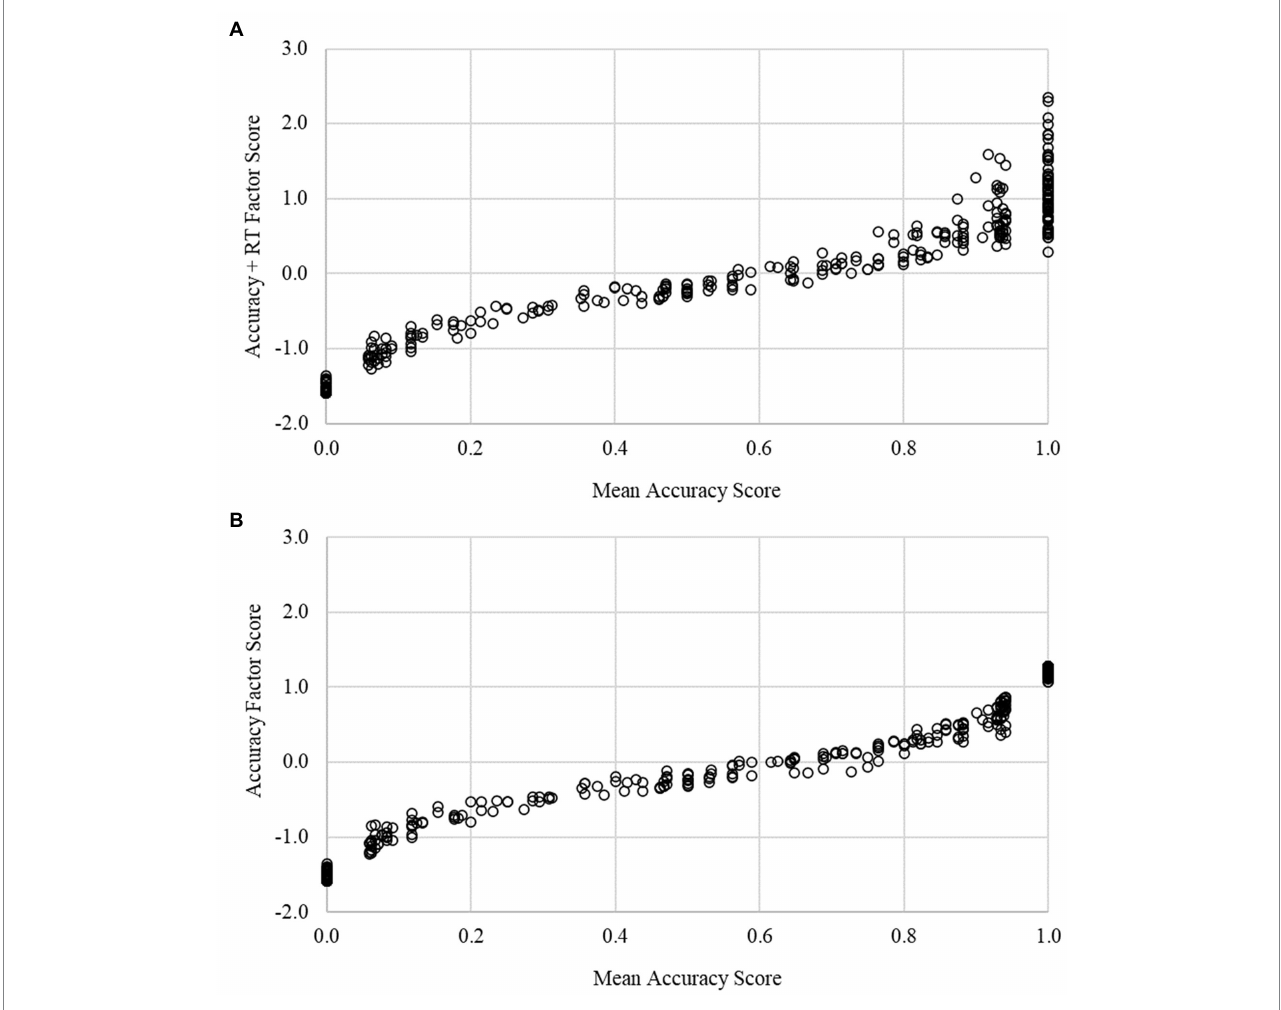
FIGURE 2 Score comparisons for the Arrows task. This figure plots mean accuracy scores against the enriched ( A ) and accuracy ( B ) factor scores. Ceiling effects (mean accuracy scores equal to 1.0) are mitigated using enriched, but not accuracy, factor